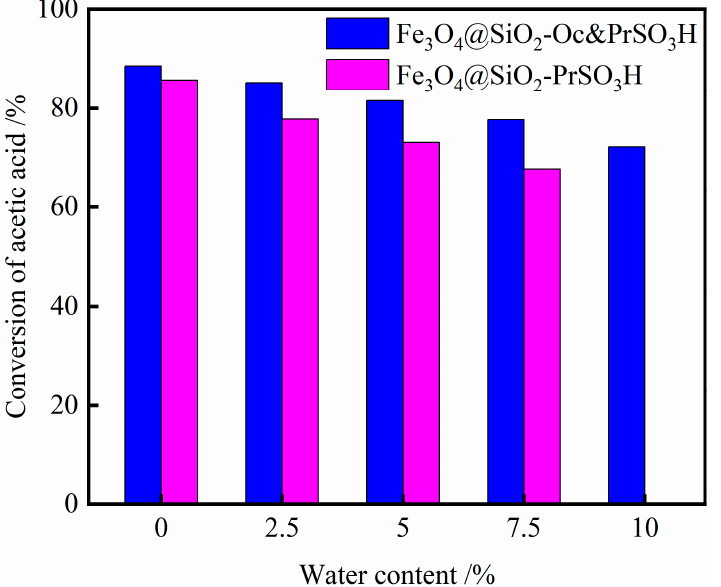
Figure 11. The influence of water content on esterification (reaction conditions: n EtOH :n HOAc = 6:1, 1 wt% catalyst loading, 80 °C, 3 h, 640 rpm).